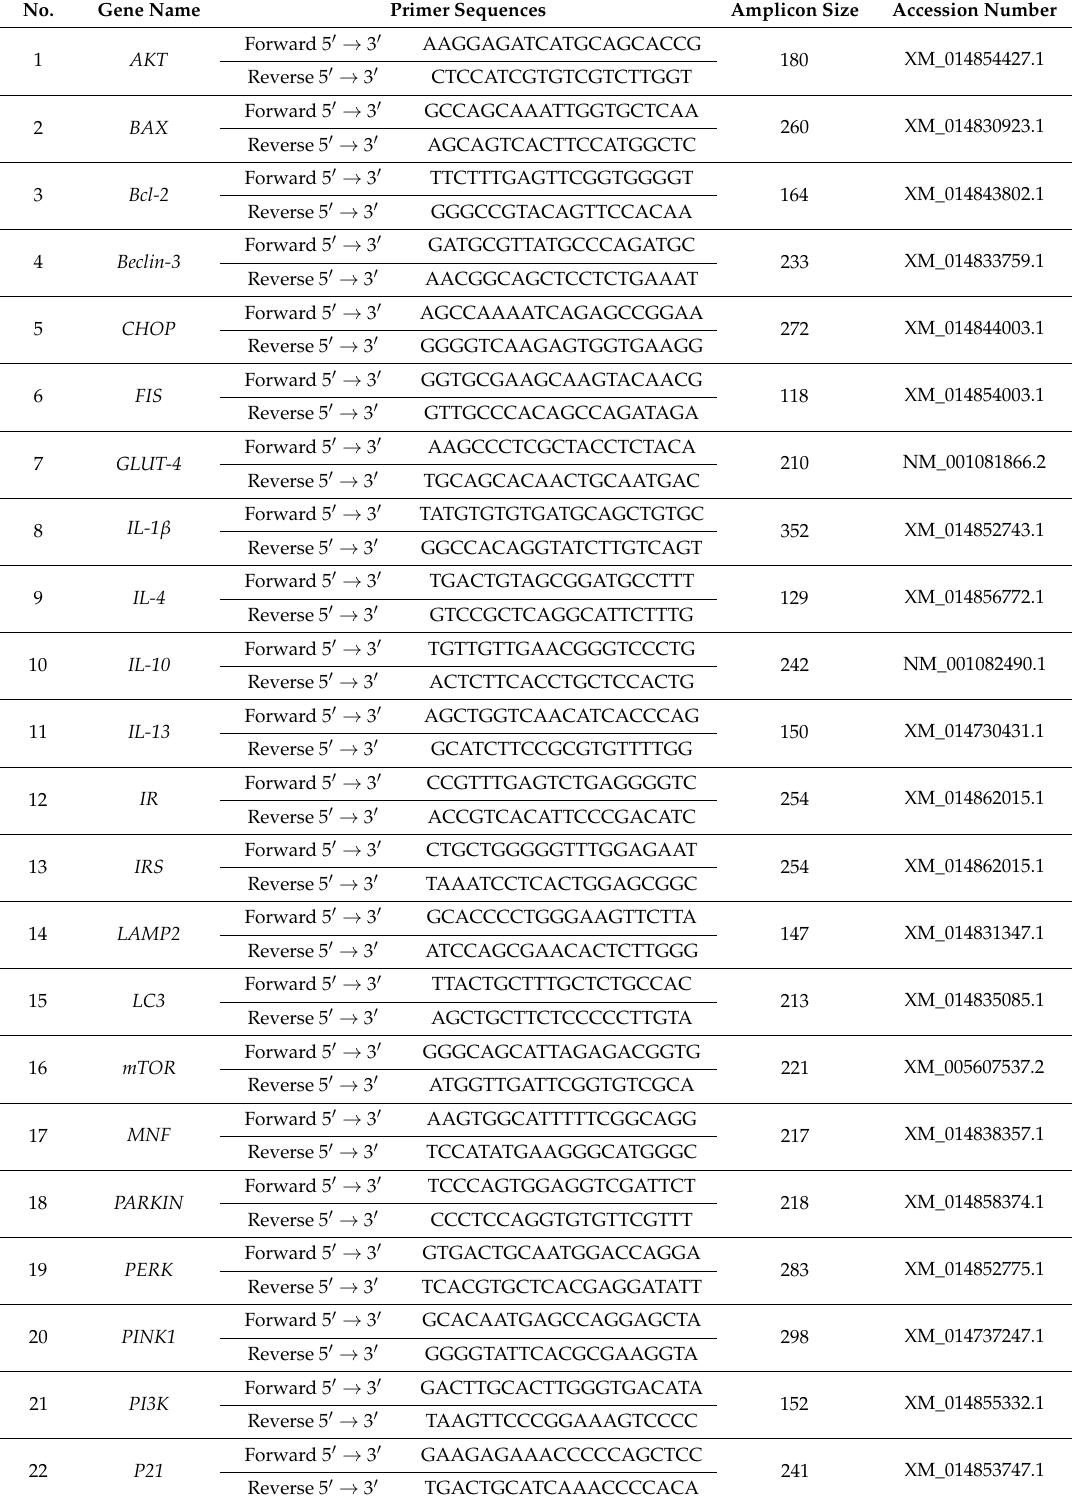
Table 2. Sequences of primers used in